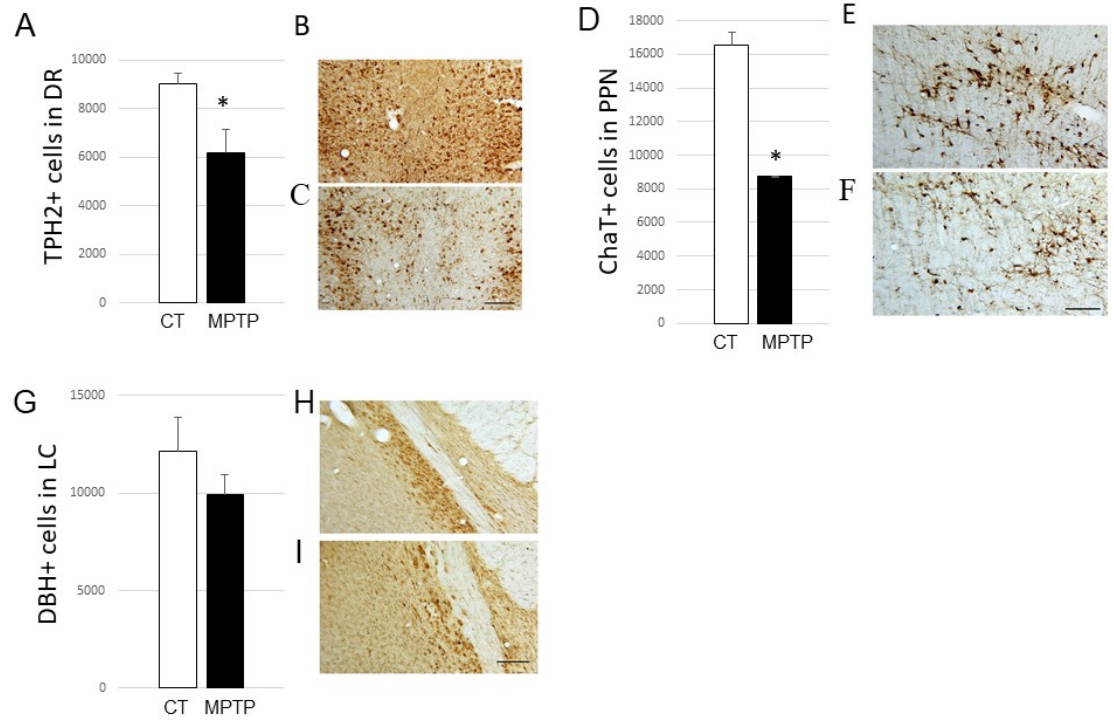
Figure 3. ( A ) Histogram represents the number of TPH2-positive cells in DR from control (CT, n = 5) and MPTP-intoxicated (MPTP, n = 6) animals. * p < 0.05 when compared to controls. ( B , C ) Photomicrographs at high magnification ( × 16) of coronal sections of a control (MF15) and an MPTP-intoxicated (MF18) Macaca fascicularis, exemplifying TPH2 labeling obtained at the level of the dorsal raphe. Scale bar on C is 100 µ m. ( D ) Histogram represents the number of ChaT-positive cells in PPN from control (CT, n = 4) and MPTP-intoxicated (MPTP, n = 3) animals. * p <0.05 when compared to controls. ( E , F ) Photomicrographs at high magnification ( × 16) of coronal sections of a control (MF14) and an MPTP-intoxicated (MF16) Macaca fascicularis, exemplifying ChaT labeling obtained at the level of the pedunculopontine nucleus. Scale bar on F is 100 µ m. ( G ) Histogram represents the number of DBH-positive cells in LC from control (CT, n = 3) and MPTP-intoxicated (MPTP, n = 3) animals. ( H , I ) Photomicrographs at high magnification ( × 16) of coronal sections of a control (MF24) and an MPTP-intoxicated (MF1) Macaca fascicularis, exemplifying DBH labeling obtained at the level of the locus coeruleus. Scale bar on I is 100 µ m. Abbreviations: TPH2, tryptophan hydroxylase 2; DR, dorsal raphe; CT, control; ChaT, choline acetyl transferase; PPN, pedunculopontine nucleus;